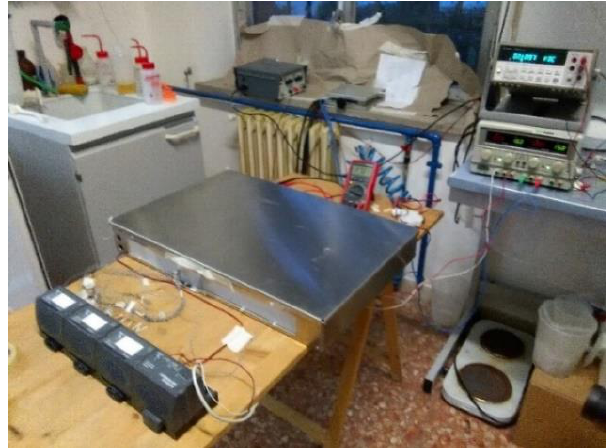
Figure 9. The battery module connected to the power sinks, located outside the window, during the discharge test.